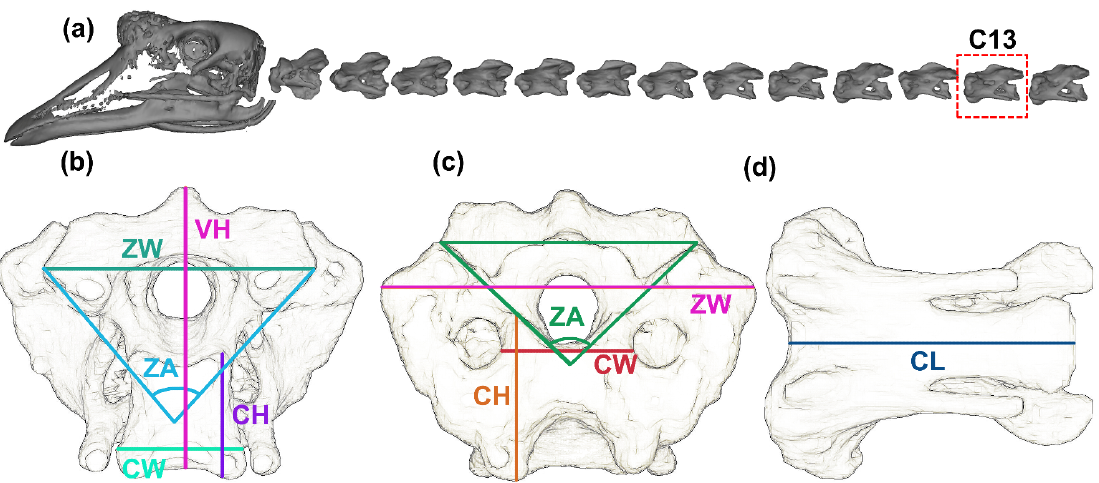
Figure 1. Tri-view measurement of the cervical spine. ( a ) C1-C14 cervical vertebrae. The front view ( b ), rear view ( c ) and side view ( d ) of C13. VH: vertebral height; ZW: zygapophyseal width; ZA: zygapophyseal angle; CH: centrum height; CW: centrum width; CL: centrum length.